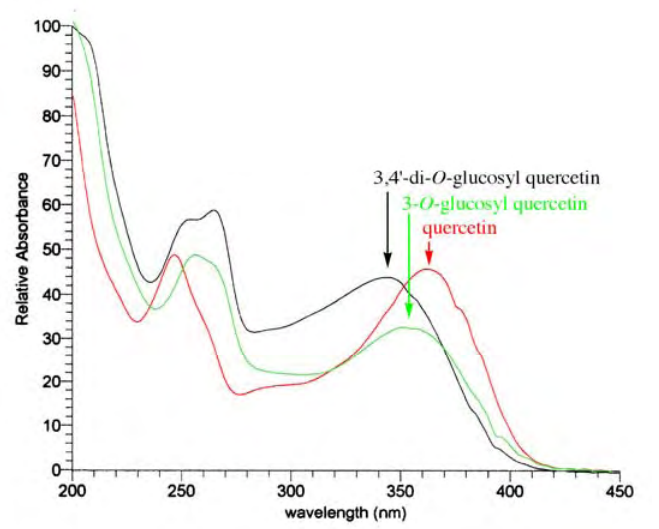
Figure 3. UV Spectra of quercetin ( 10 , red trace), 3- O -glucosyl quercetin (green trace), and 3,4’-di- O -glucosyl quercetin (black trace).